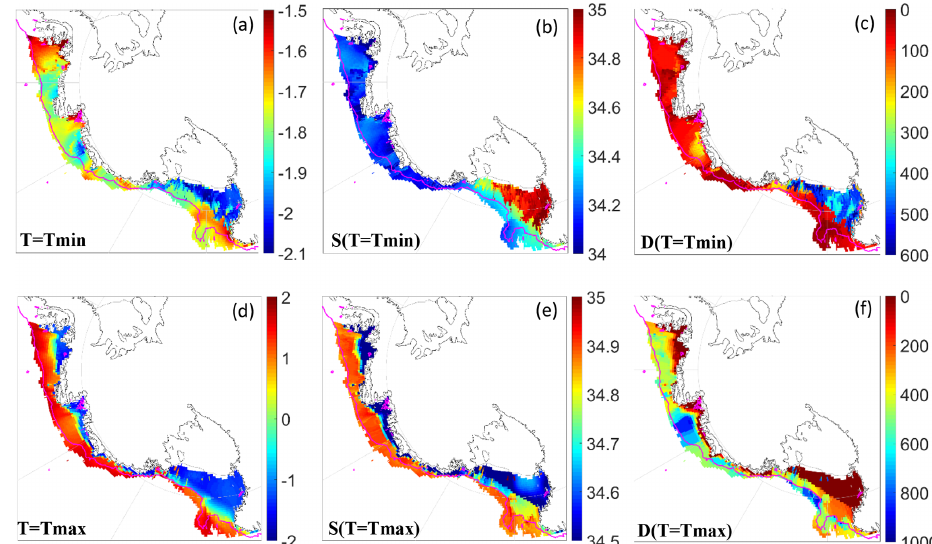
Figure 2. Clustering metrics in WOA. Minimum temperature at each grid point (a) and the salinity (b) and water depth at the minimum temperature. Panels (d) – (f) are the same as (a) – (c) but for quantities at the temperature maximum.